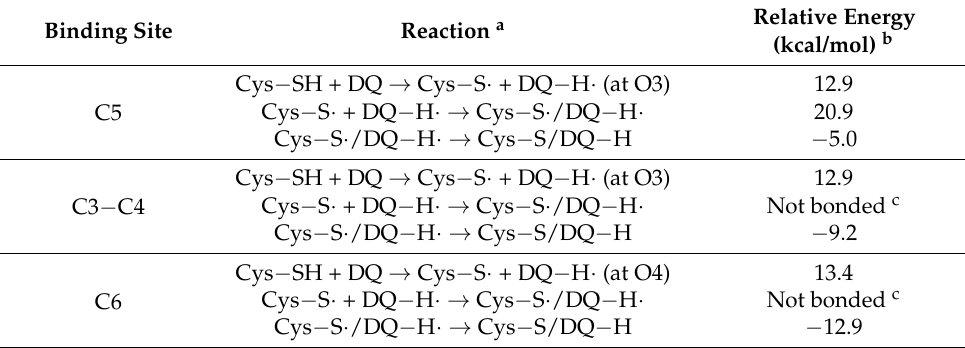
Table 3. Reaction energy for radical coupling reaction.